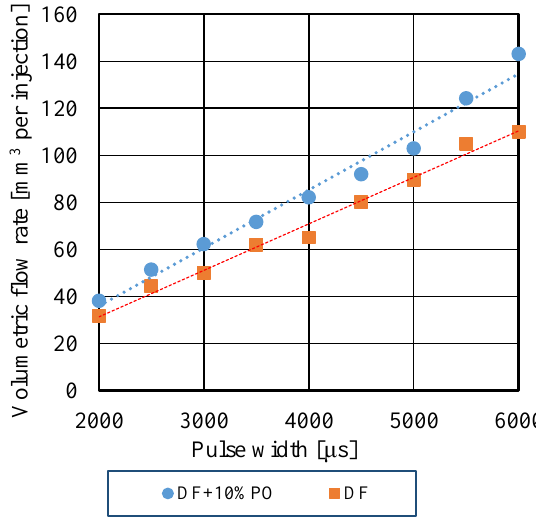
Fig. 11. Characteristic curves of the injection rate for both fuel From the injector characteristics it can be seen that the addition of 10%PO increases volumetric flow. Based on the measurement of the amount of fuel burned in a given Fig. 9. Rate of pressure rise vs. crank angle